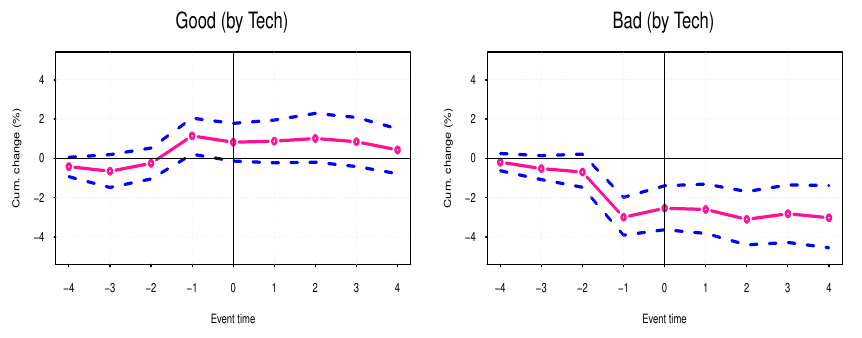
Figure 9. Extreme event on Tech and response of WTI oil.